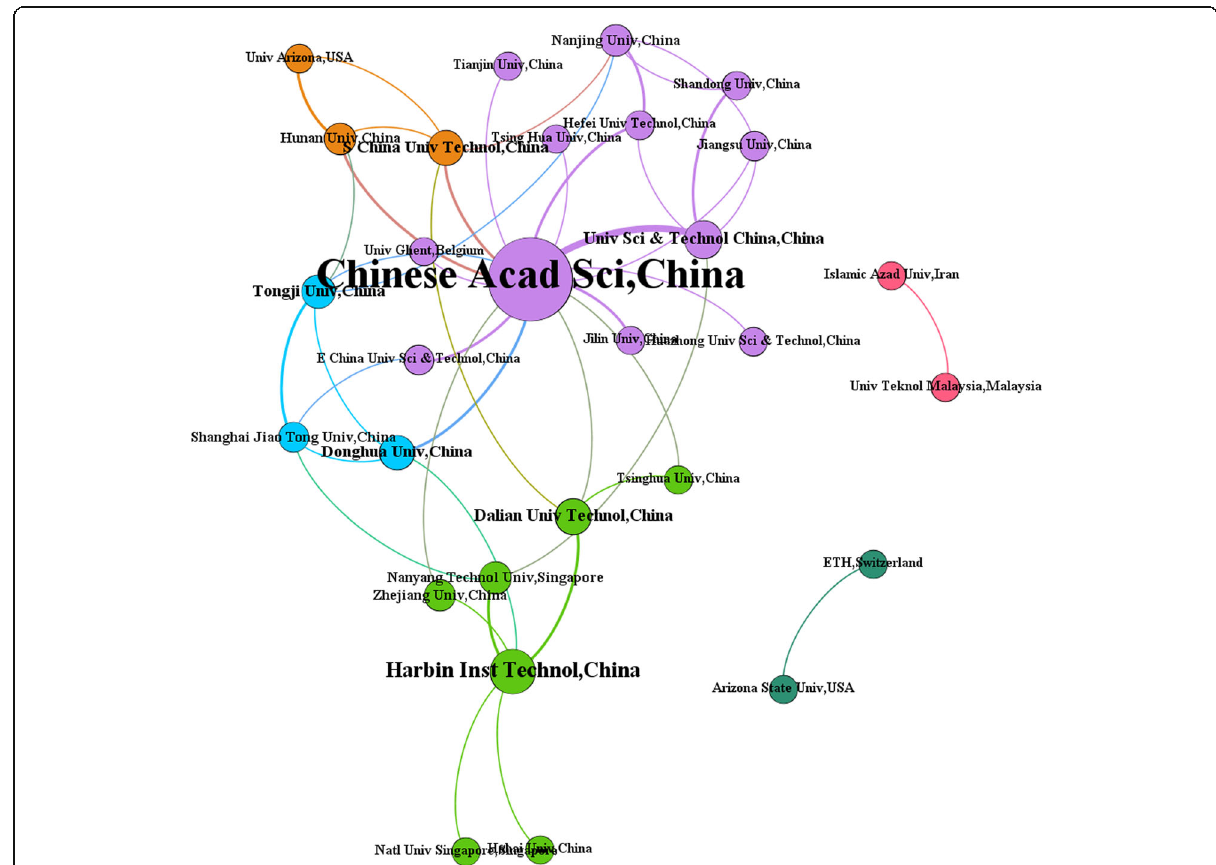
Fig. 3 The cooperation network of the top 30 productive institutions